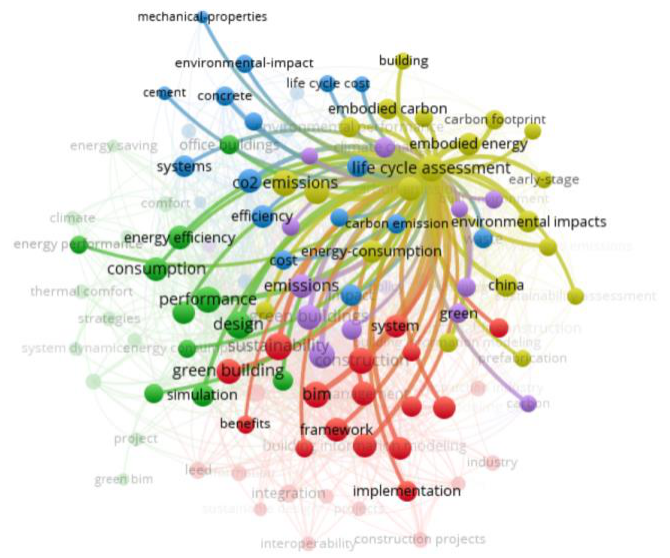
Figure 5. Network-visualization map with the theme of lifecycle assessment (further revealed in detail in Figure 4) in the WoS-core-collection database via VOSviewer software (generated by the